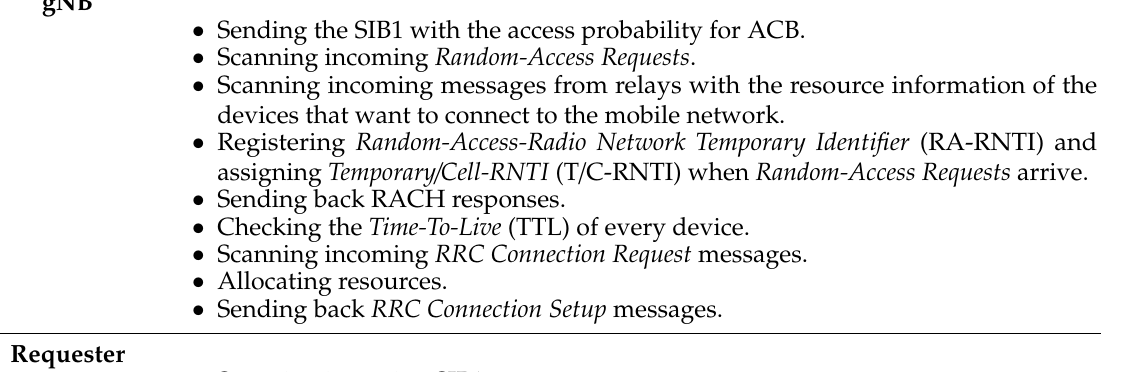
Table 1. Functionalities of the gNB, the requester, and the